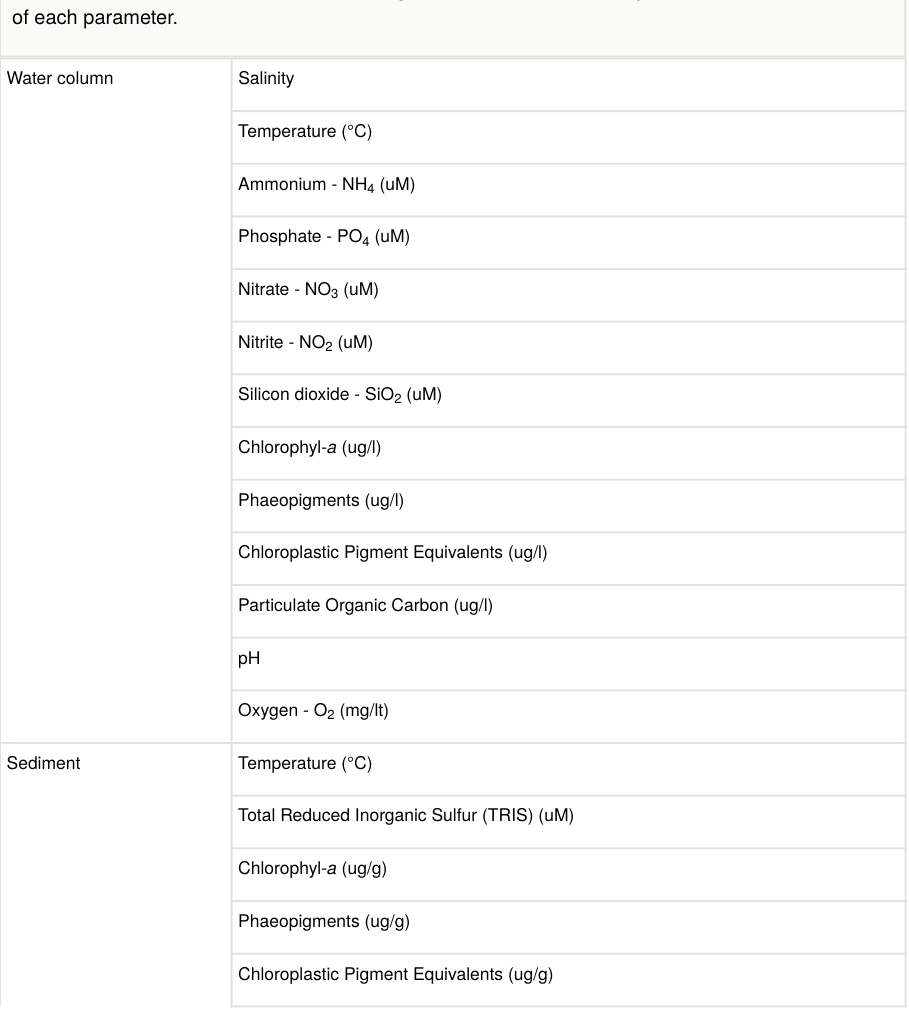
The abiotic variables measured from the lagoons of Amvrakikos. The parenthesis include the units of each